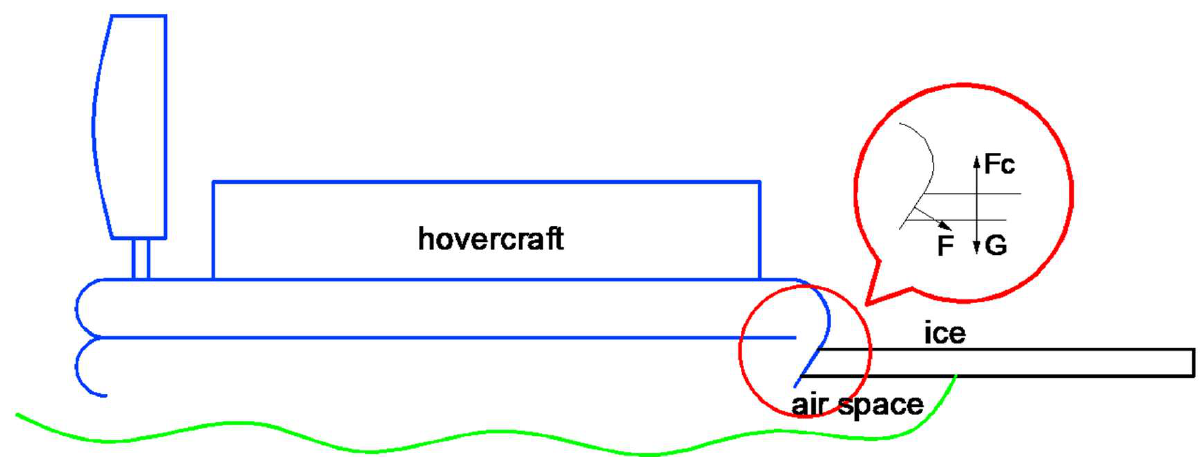
Figure 1. Ice breaking mechanism.